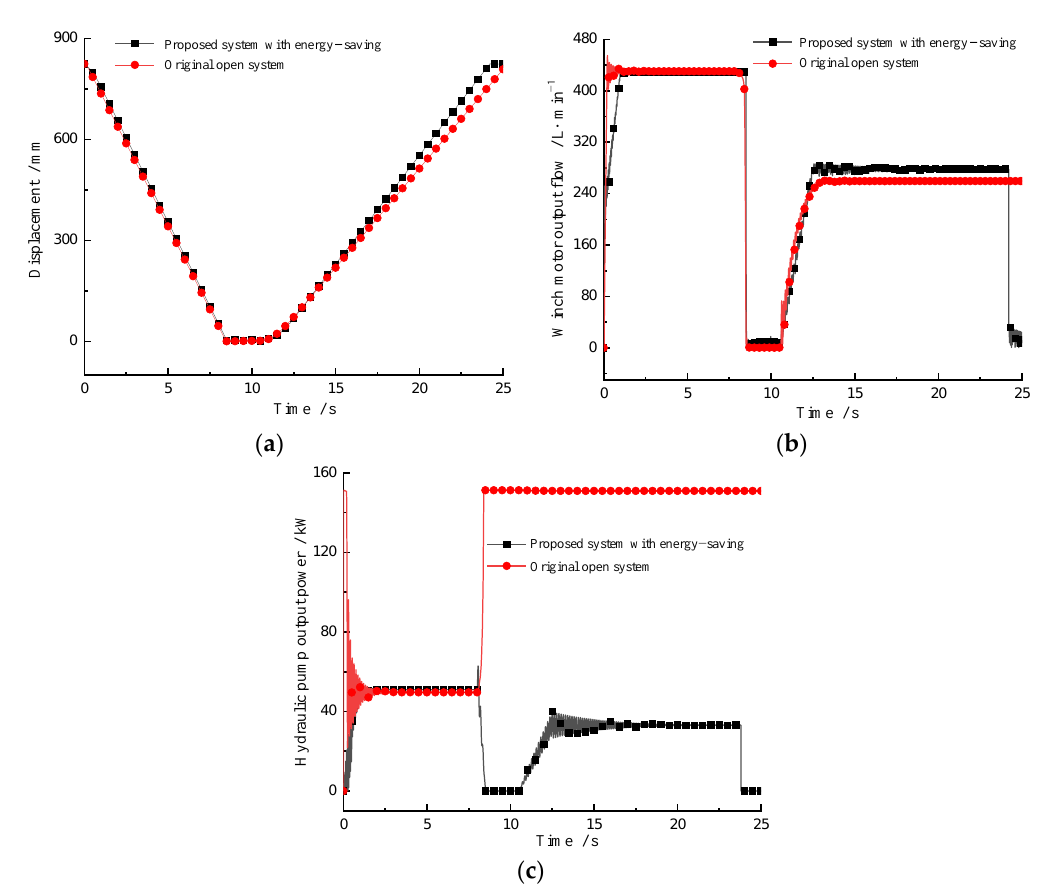
Figure 4. Volume and pressure change of the proposed system when winch lifting and descending. ( a ) Accumulator volume change; ( b ) Accumulator pressure change.